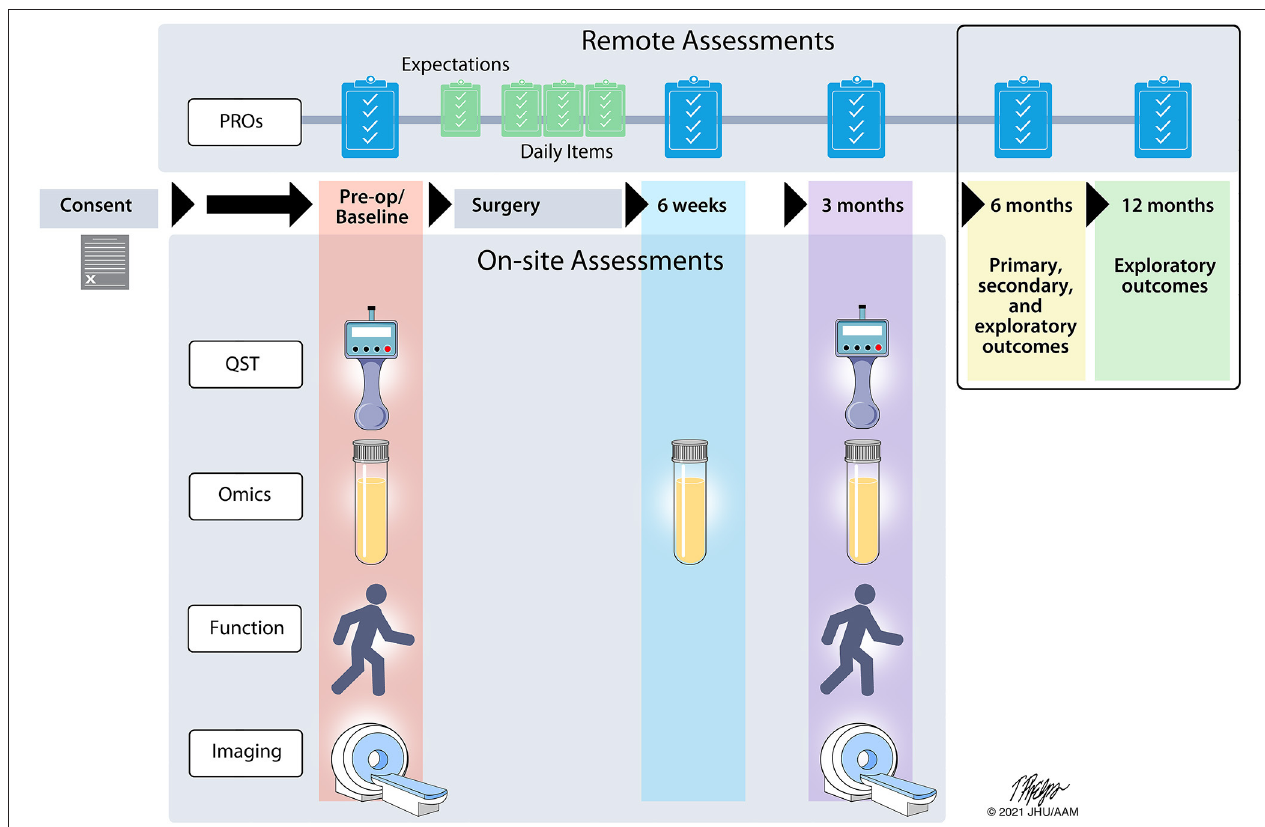
FIGURE 1 | A2CPS study timeline. The flow of assessments is indicated across the 12-month study timeline. Remote assessments consist of patient reported outcomes (PRO) while onsite assessments involve quantitative sensory testing (QST), a blood draw for high-throughput screening techniques (omics), physical function, and brain